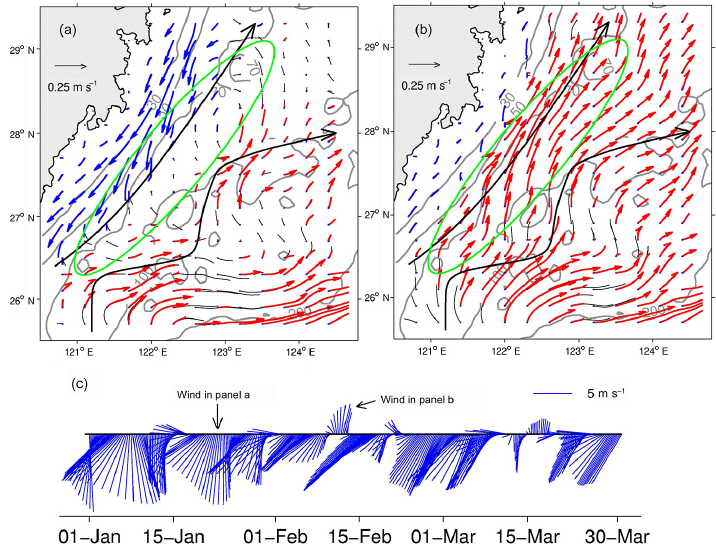
Figure 16. The VMV under the northerly wind (a) and southerly wind (b) . (c) shows the variation of wind in winter. Blue vectors and red vectors show the southwestward coastal current and the northeastward TWC, respectively. Gray contours indicate the 30, 50, 70, and 100m isobaths. The two black arrows represent the two TWC branches. The green ellipse indicates the inshore area with significant